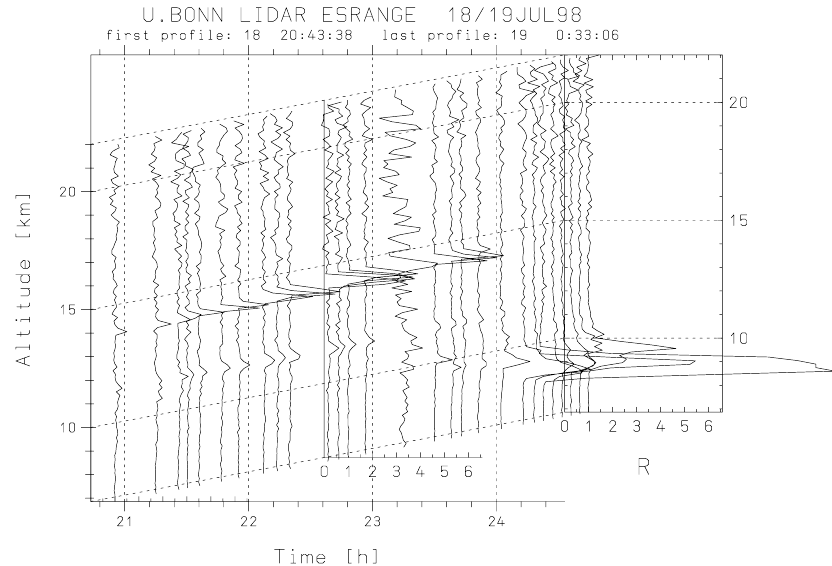
Fig. 2. Temporal evolution of the clouds above Esrange on July 18, 1998, from 2043 to 0033 UT. Shown are stacked profiles of the backscatter ratio for the parallel polar- ization returns at 532